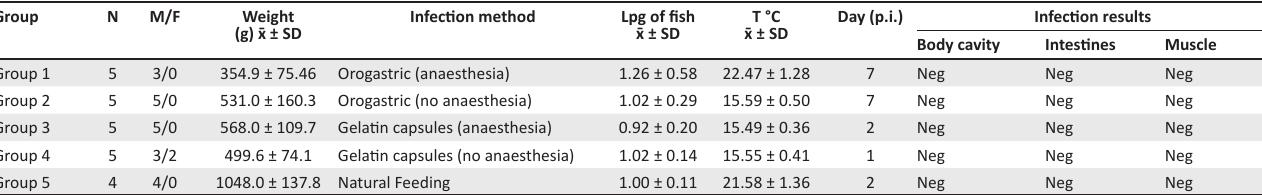
TABLE 1: Results from experimental infection of African sharp tooth catfish ( Clarias gariepinus ) with Trichinella zimbabwensis. Group N M/F Weight